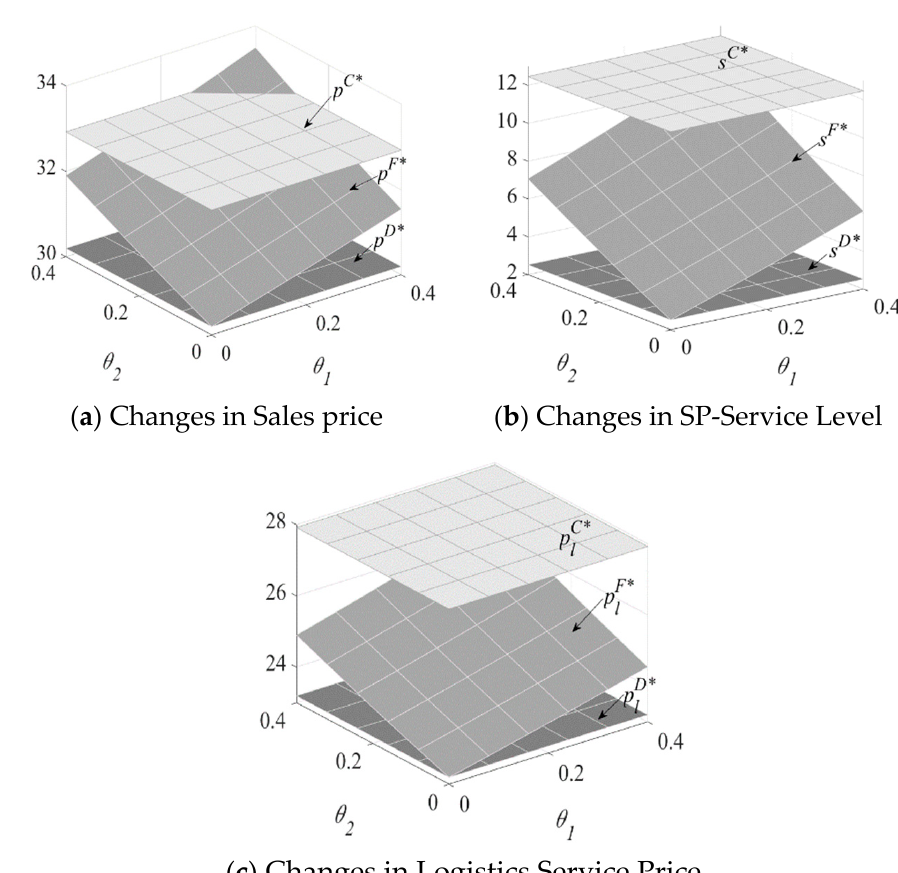
Figure 3. Changes in decision variables with θ 1 and θ 2 .